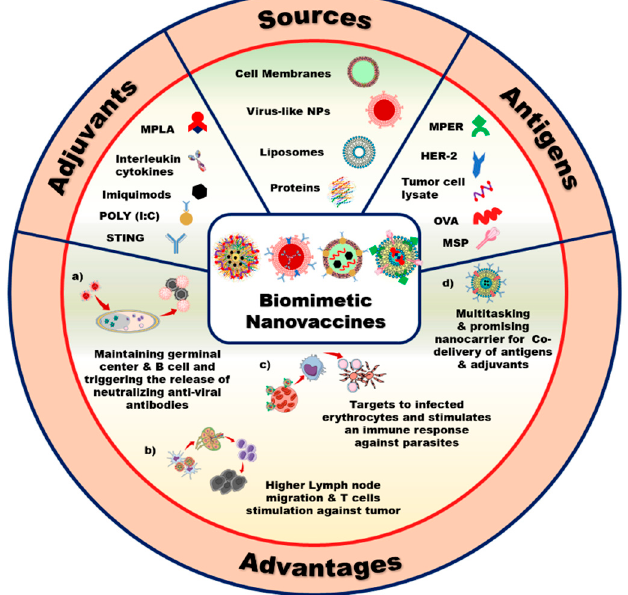
Figure 1. Schematic of different formulations of biomimetic nanovaccines and their advantages. a )